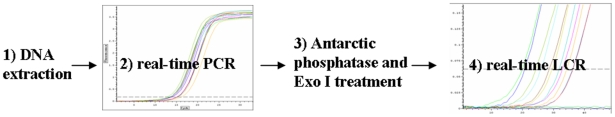
Schematic representation of the entire process for SNP detection and quantification.